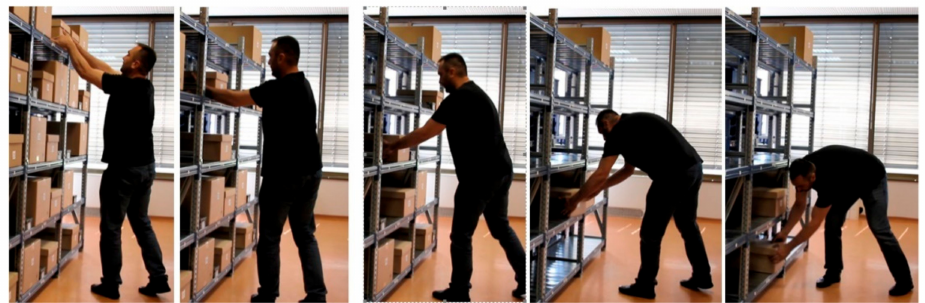
Figure 5. Observation of work postures during the order picking